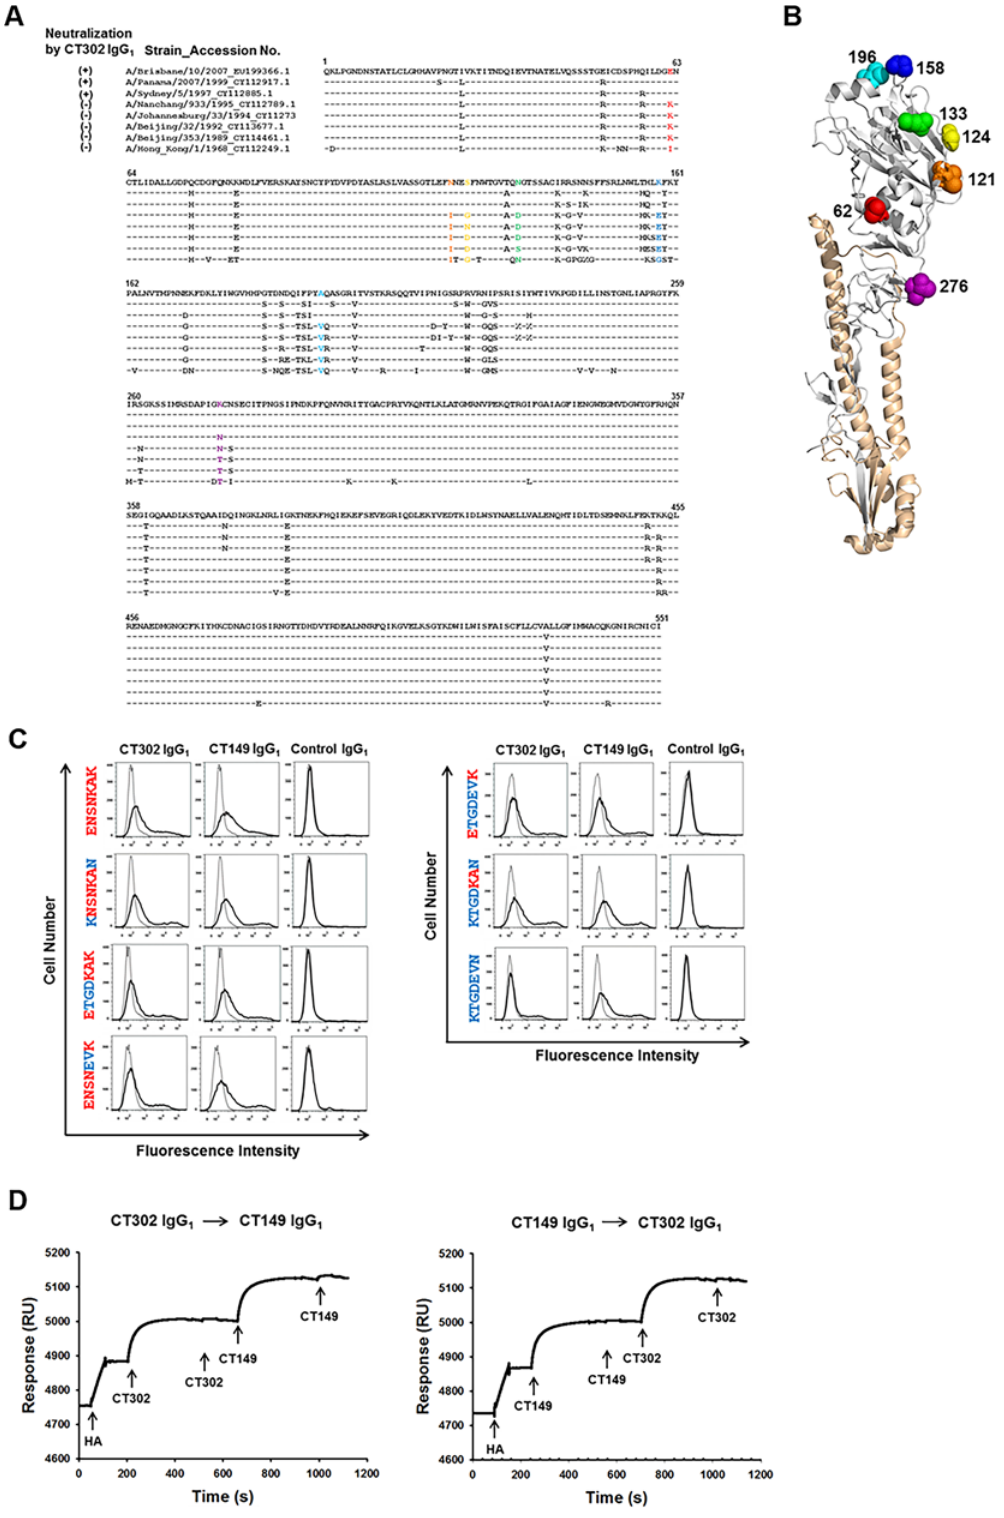
Fig 5. Binding activity of CT302 IgG 1 to HA mutants. (A) Globular head domain of HA protein is composed of residues 52 to 277. The amino-acid sequences for HA protein were downloaded from the Influenza Virus Resource at the National Center for Biotechnology Information (NCBI). The NCBI